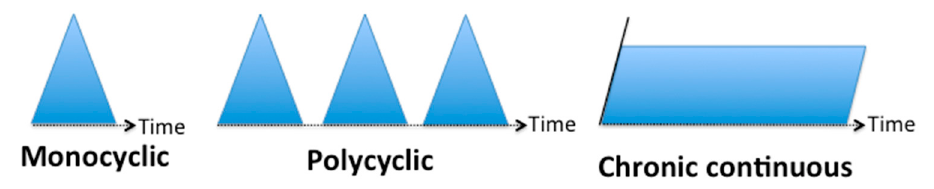
Figure 1. AOSD phenotypes based on the evolution of symptoms over time